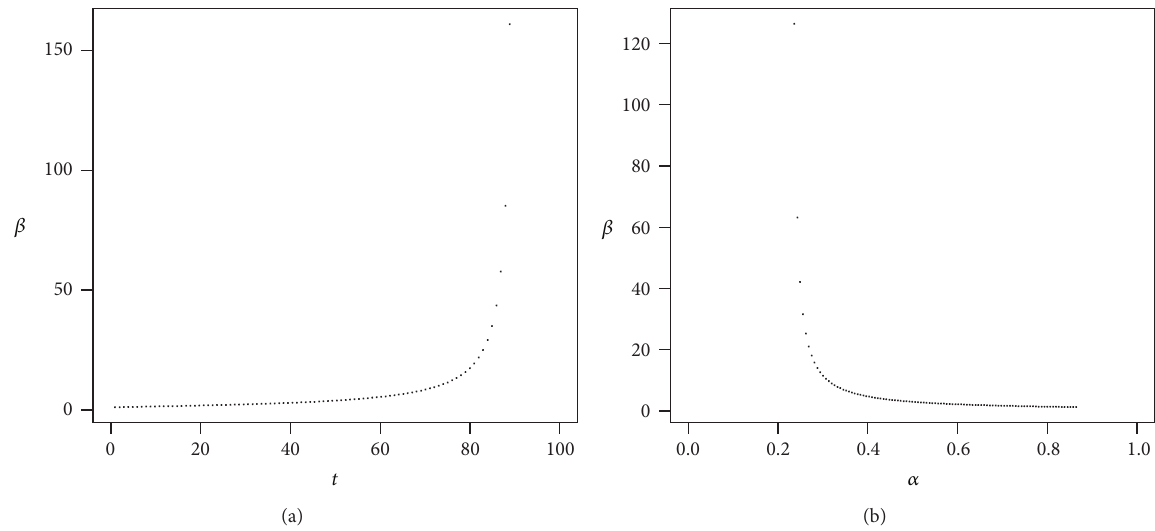
Figure 7: Medium volatility of returns (optimistic). The plot shows 𝛽 as a function of 𝑡 with 𝛼 = 50 % (a) and 𝛽 as a function of 𝛼 with 𝑡 = 40 (b). Parameters are 𝑟 = 4 %, 𝜇 = 10.5 %, 𝜎 = 25 %, ] = 1.1 %, and 𝛾 = 10 %.